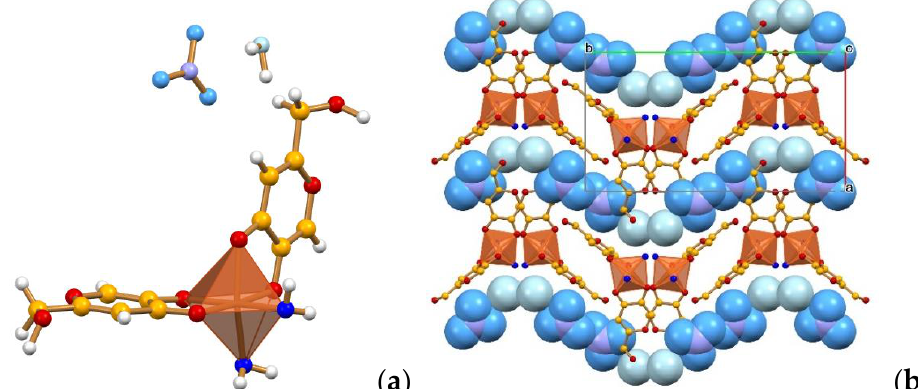
Figure 4. Crystalline [Ga(KA) 2 (OH 2 ) 2 ][NO 3 ]∙H 2 O: ( a ) Octahedral coordination around the Ga 3+ cation, and ( b ) intercalation of nitrate anions/water molecules between wavy layers of cations extending along the b -axis direction. (H atoms not shown for clarity.) Water oxygens are in blue (coordination sphere) and light blue (external); nitrate oxygens are in cyan, and nitrogens are in violet.